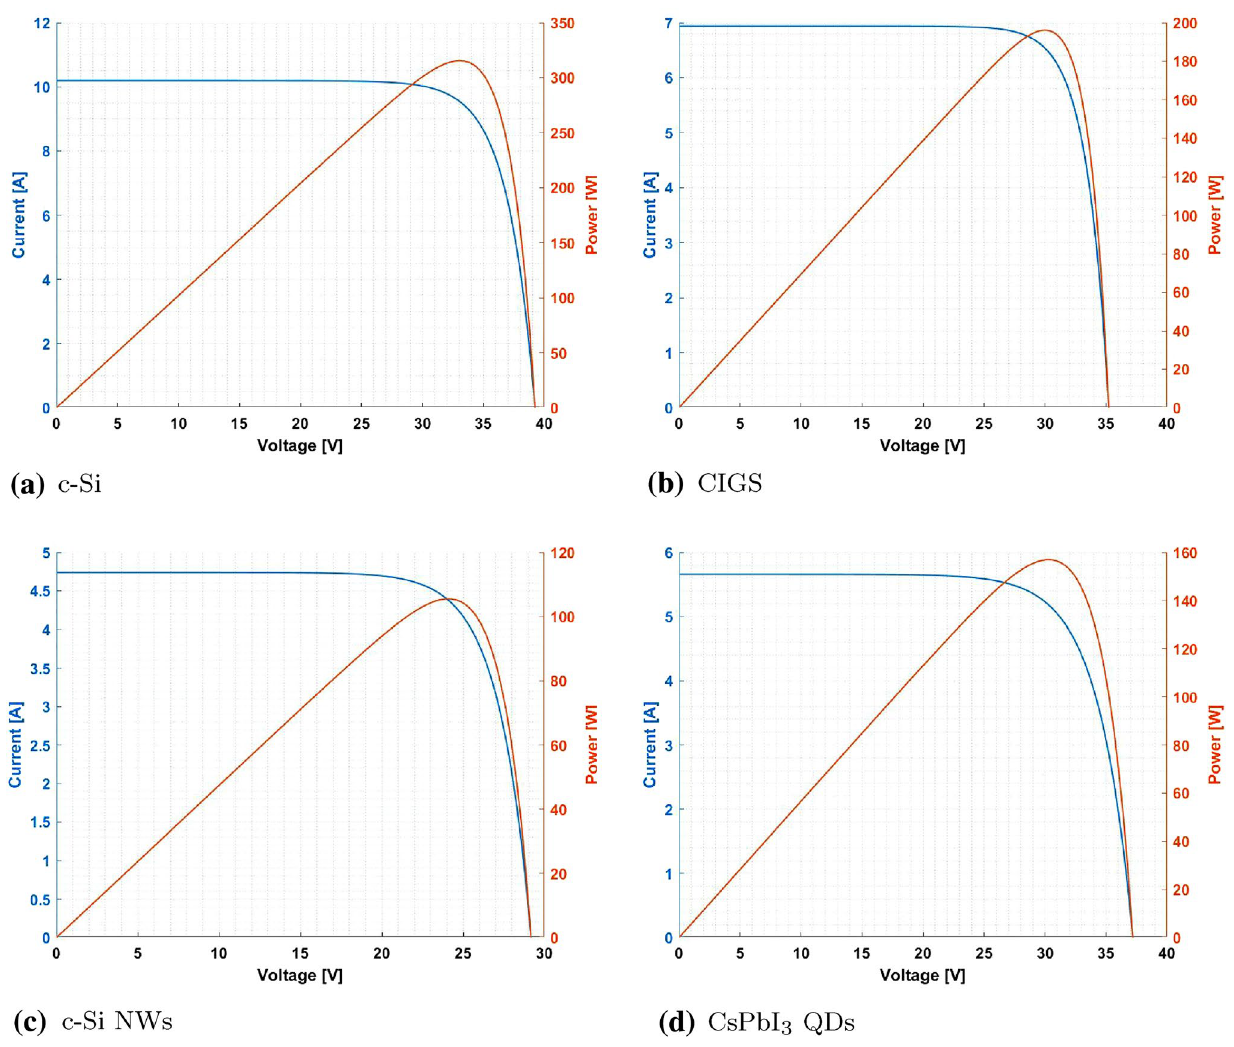
Fig. 3 Solar panels’ characteristics